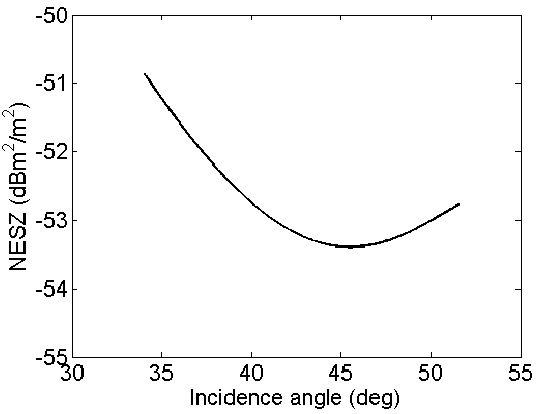
Figure 4. SETHI instrument noise floor (NESZ) plotted by increasing incidence angle—reproduced from [12].